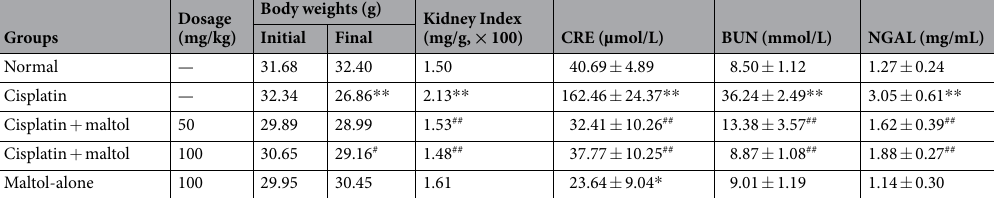
Table 1. Effects of maltol on body weights, kidney indices, and serum biochemical markers in mice. Values represent the mean ± S.D., n = 8; ** p < 0.01, * p < 0.05 vs . normal group; ## p < 0.01, # p < 0.05 vs . cisplatin group.